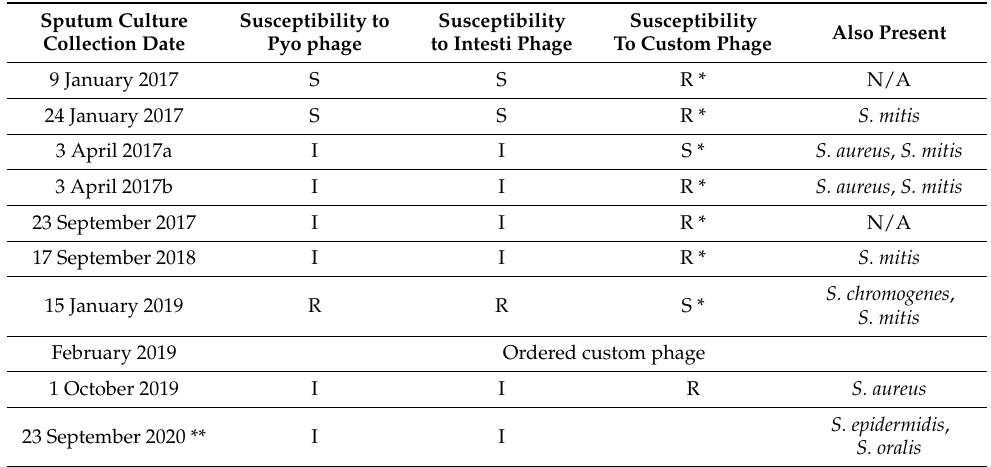
Table 2. Phage susceptibility of Pseudomonas aeruginosa sputum cultures of patient #1: strain sensitive to phage (S), intermediate sensitivity (I), strain resistant to phage (R). * Custom phage susceptibility of strains isolated before custom phage preparation. ** Bacterial strains isolated in or after 2020 were not included in the